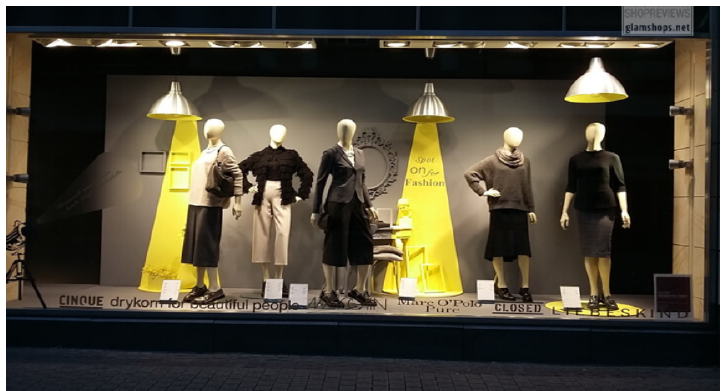
Figure 1. Closed display window style.